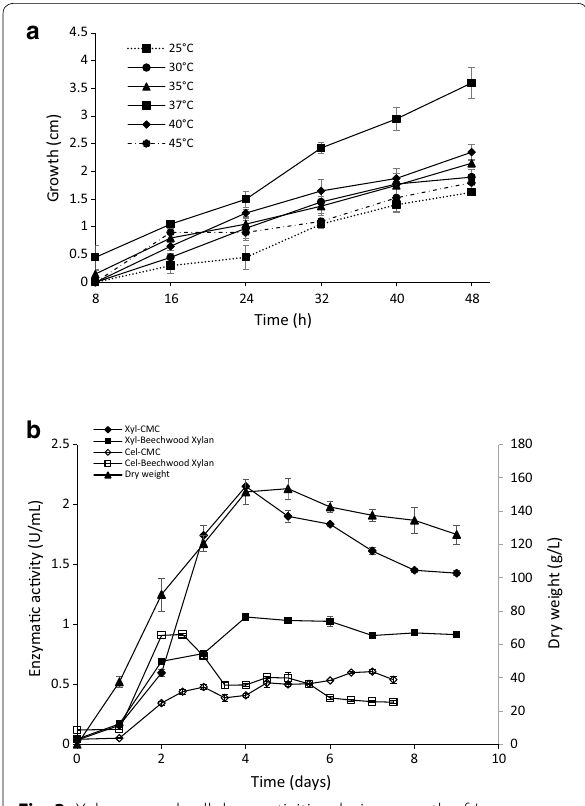
Fig. 3 Xylanase and cellulose activities during growth of L. ramosa H71D. a Radial growth kinetic of L. ramosa H71D at different growth temperatures on PDA agar, the diameter was measured every 8 h for 48 h. b Growth and enzyme activities (xylanase and cellulose) of L. ramosa H71D at 37 °C. Dry weight in Mandels and Sternberg culture medium (Black up‑pointing triangle). Xylanolytic activity produced on CMC (Black diamond suit) or Beechwood xylan (Black square), as a carbon source. Cellulolytic activity produced on CMC (Lozenge) or Beechwood xylan (Square), as a carbon source